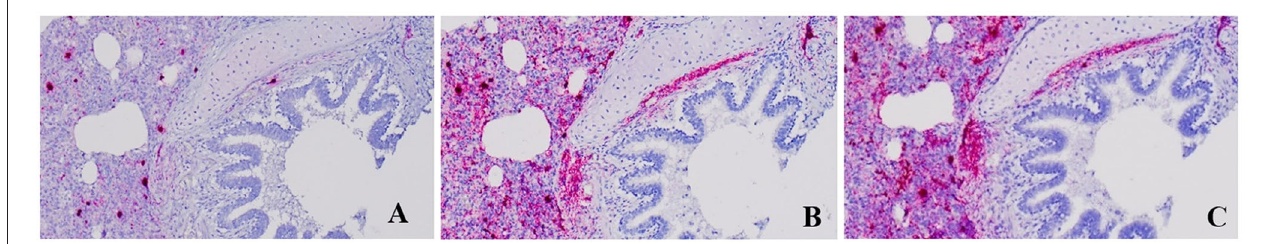
FIGURE 4 | Detection of porcine parvovirus 2 (PPV2) by in situ hybridization (ISH × 200). The ISH signal of PPV2 was markedly reduced in formalin-fixed paraffin-embedded (FFPE) sections treated with DNase (A) compared to untreated FFPE sections (C) . There was no obvious difference between the FFPE sections treated with RNase (B) and the untreated FFPE sections (C)